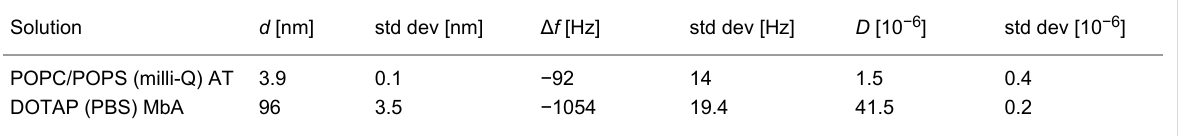
Table 1: Shift in frequency Δ f and shift in dissipation D and relative standard deviations of the layers adsorbed on the QCM sensor’s surface. Every experiment was repeated three